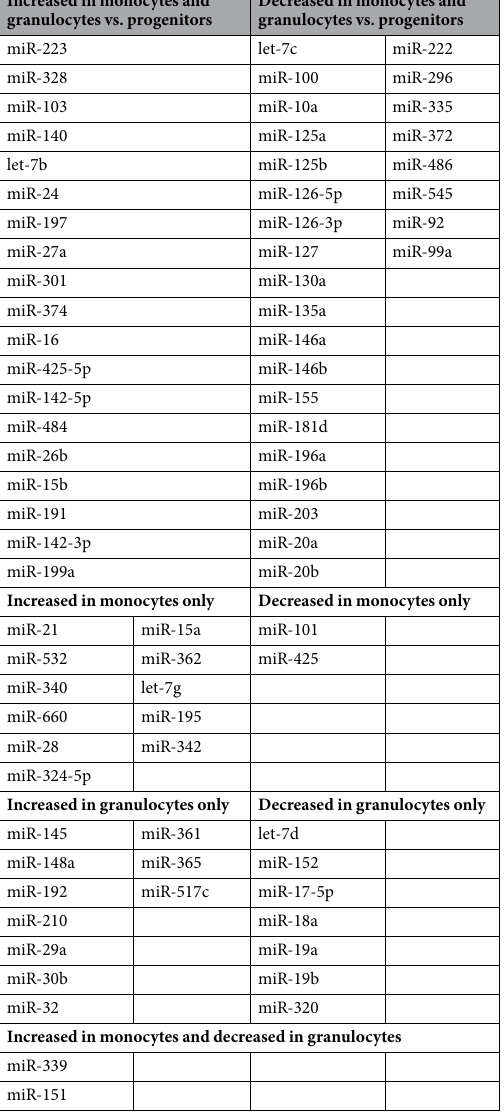
Table 1. MicroRNAs that are differentially expressed by at least 2-fold between myeloid progenitors and corresponding monocytes and